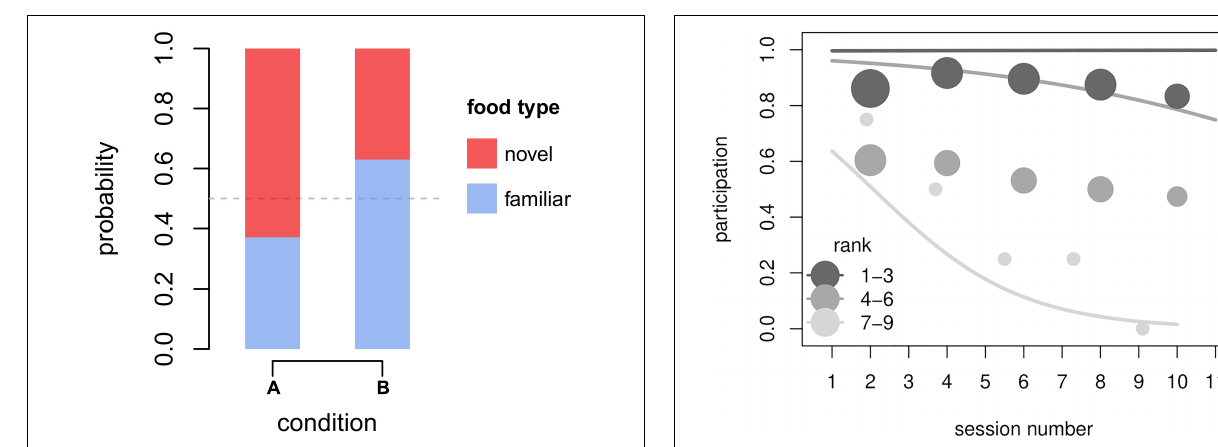
FIGURE 2 | Results from model M3. Participation in an experimental session as a function of the interaction between rank and session number . Lines show probabilities to participate in a session according to the (binned) session number and (binned) ranks as estimated by model M3 (all other predictors were kept at their sample mean). Circles show the observed frequency of participation for each rank and session bin. Shade of lines and circles represents rank (darker = higher ranking, see legend). Circles size is proportional to the number of sessions for each rank and session number bin. High-ranking individuals participated more often overall, and participation of lower-ranking individuals decreased markedly throughout the course of the experiment.